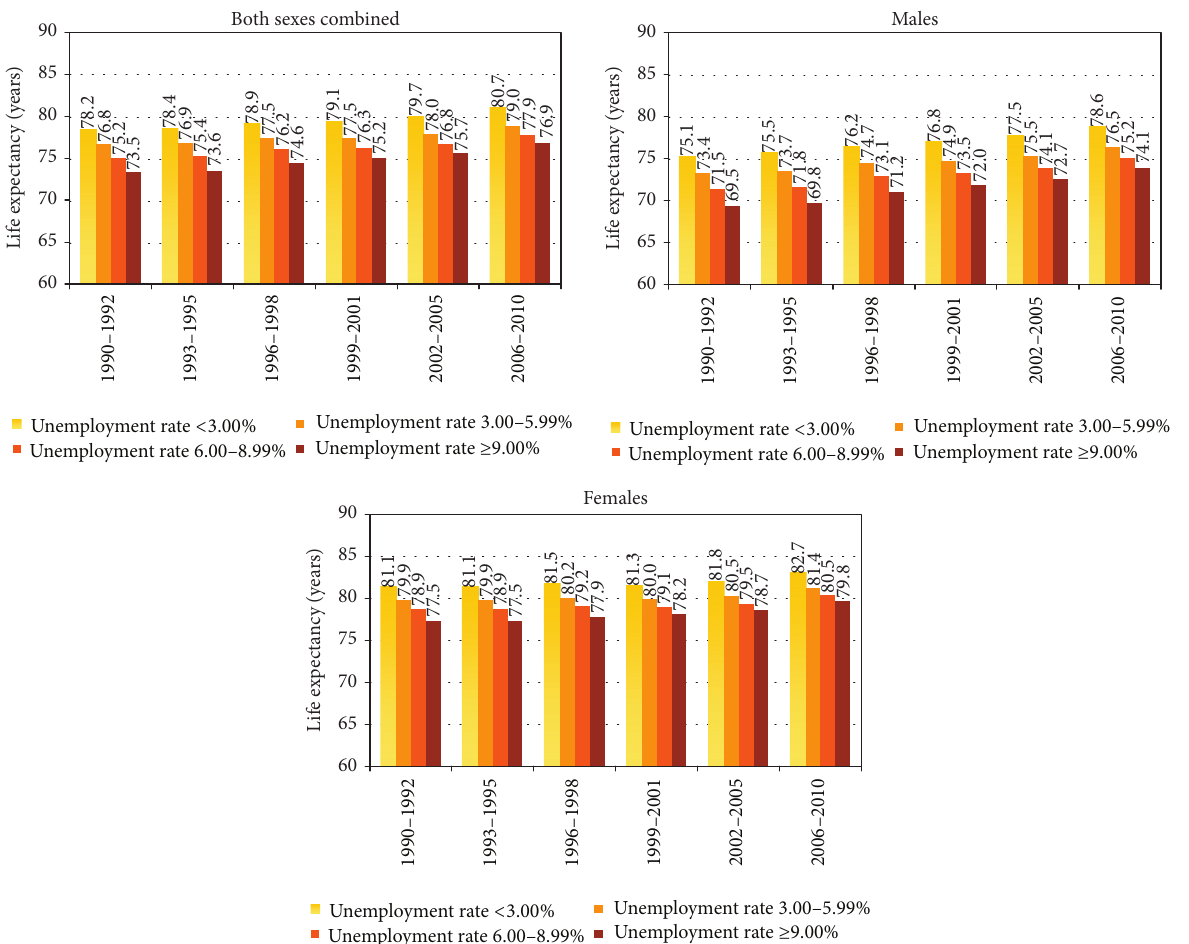
Figure 1: Life expectancy at birth by sex and area unemployment level, United States,